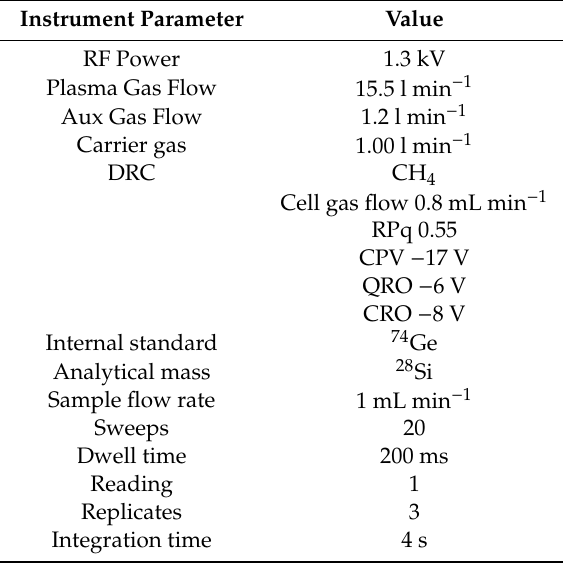
Table 1. Optimized instrument